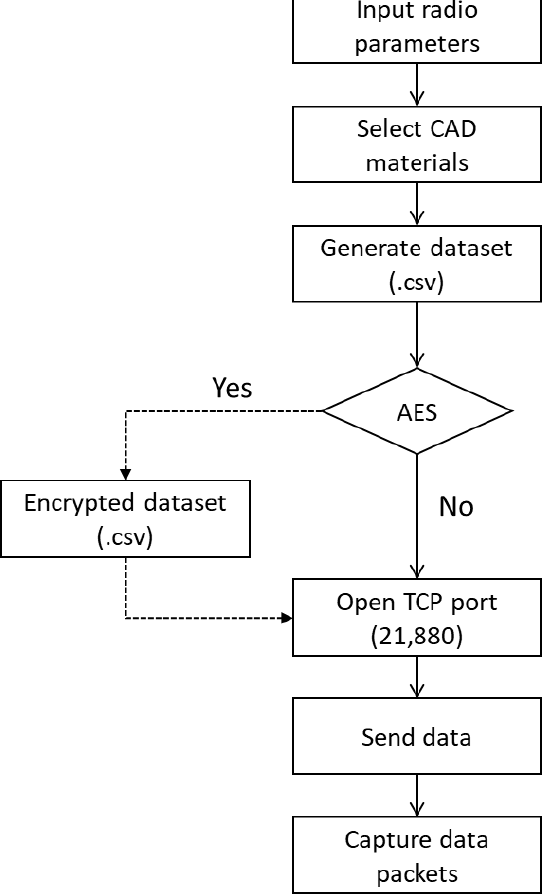
Figure 4. 5G digital twin workflow.